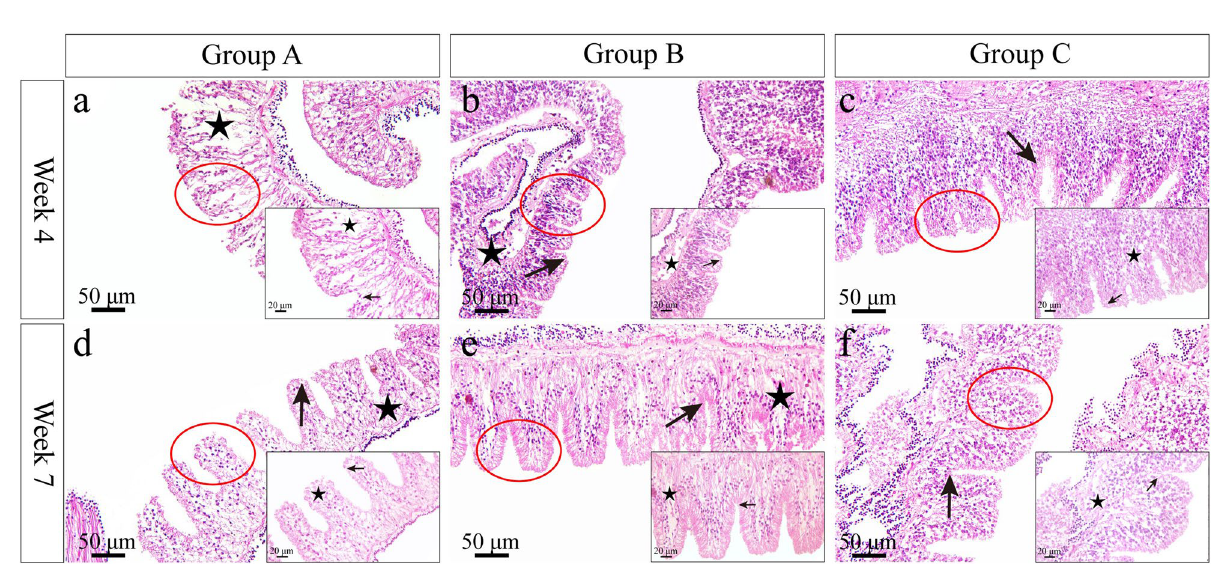
Figure 6. Gut morphology in Strongylocentrotus intermedius of the experimental groups in week 4 and week 7. The red circles represent areas for further amplification. Arrows indicate plicae circulars. Stars indicate the hollowing inner